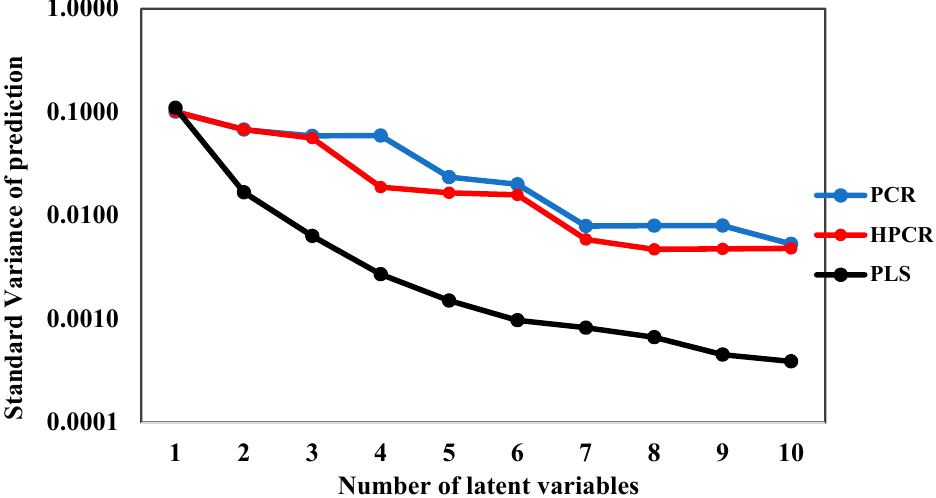
Figure 8. Correlation coefficients for PLS, PCR and HPCR models at 90 °C and 450 rpm.